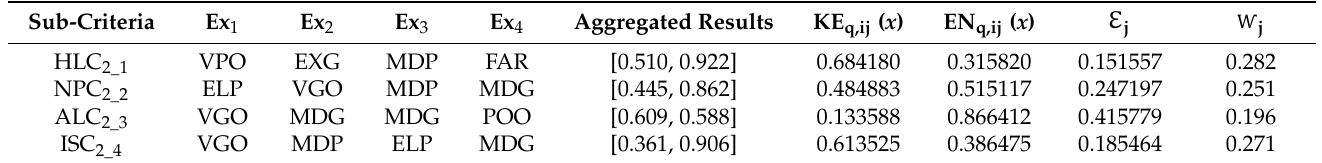
Table 7. Verbal evaluations of the audit source location’s criteria and aggregated main criteria weights.